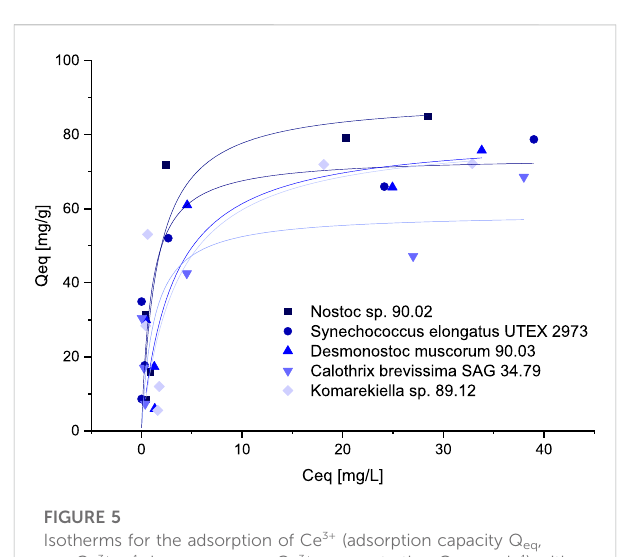
FIGURE 5 Isotherms for the adsorption of Ce 3+ (adsorption capacity Q eq ,